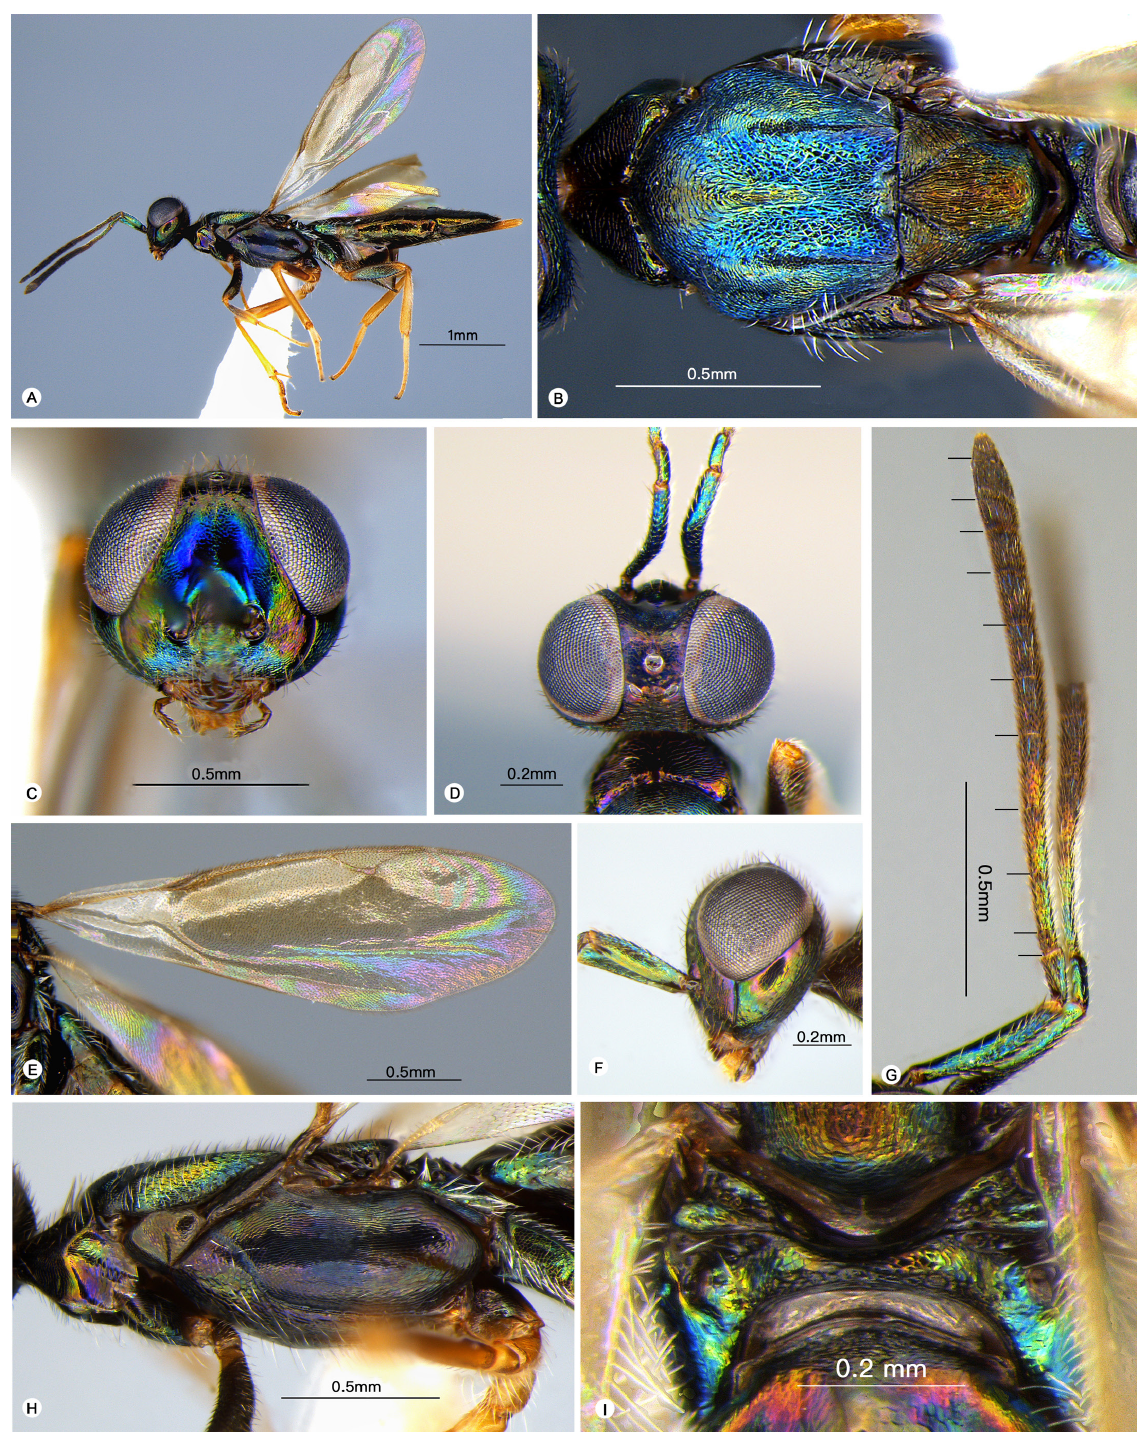
Fig. 2. Zaischnopsis fuscolivida Tang & Peng sp. nov. A . Body, lateral view. B . Mesosoma, dorsal view. C . Head, front view. D . Head, dorsal view. E . Fore wing. F . Head, lateral view. G . Antenna. H . Mesosoma, lateral view. I .